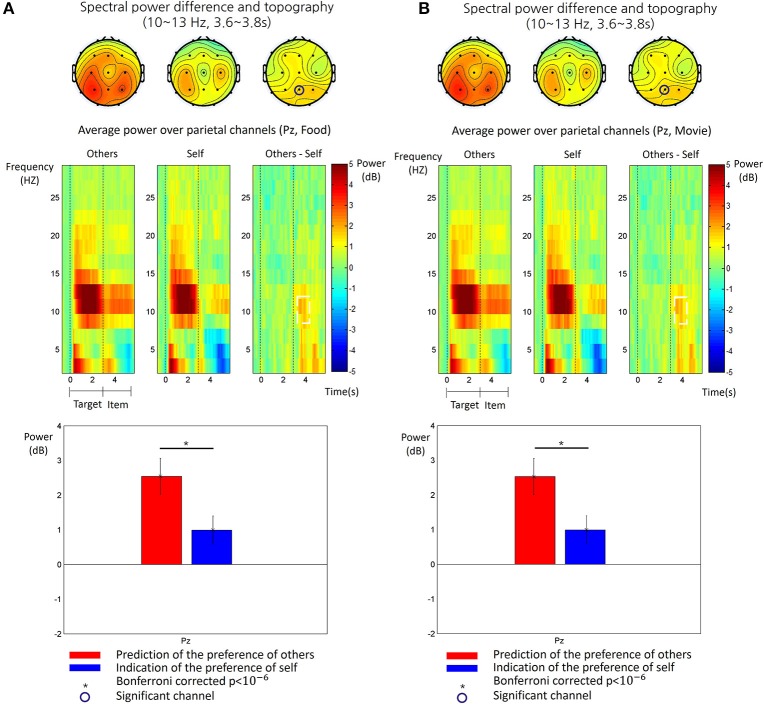
The time-frequency patterns of EEG in food stimulus trials (A) and the movie stimulus trials (B), respectively. Top: The topography of the alpha power (10~13 Hz) measured in the period of 3.6~3.8 s after the target phase, for the other-trial (left), the self-trial (center) and differences between them (right). The circled channels (Pz) showed significant differences of alpha power between the other-trial and self-trial. Middle: The time-frequency map of grand average spectral power of EEG recorded at Pz are shown for the epoch from 0.5 s before the target phase to 3 s after the item phase. The time 0 s indicates the onset of the target phase. The spectral power values were baseline-corrected by subtracting the mean value in the baseline period (−0.5~0 s) from all the values, for each frequency. The map shows the time-frequency patterns for the other-trial (left), self-trial (center) and differences between them (other-self, right). The white dotted line box indicated a time-frequency window where a significant difference between the other-trial and self-trial was found (paired t-test, p < 0.05, Bonferroni corrected). Bottom: The comparison of alpha power between the other-trial and self-trial at Pz. Alpha power in the other-trial was larger than that in the self-trial (paired t-test, p < 0.05, Bonferroni corrected). The error bar indicates the standard error of the mean.